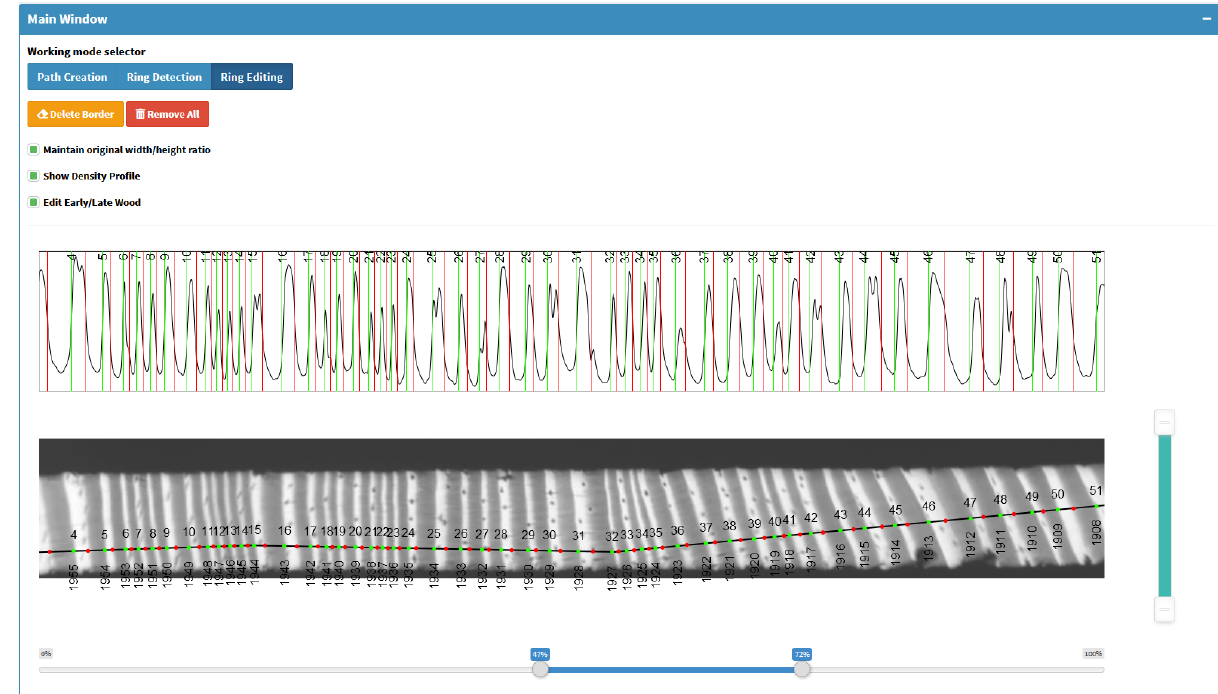
Figure 2. Working screen of ρ -MtreeRing. Full X-ray image and density profile can be visualized simultaneously with zooming options (below and right bars). Ring limits are shown with red dots and early-latewood transition in green. Limits can be deleted and located using the Ring Editing